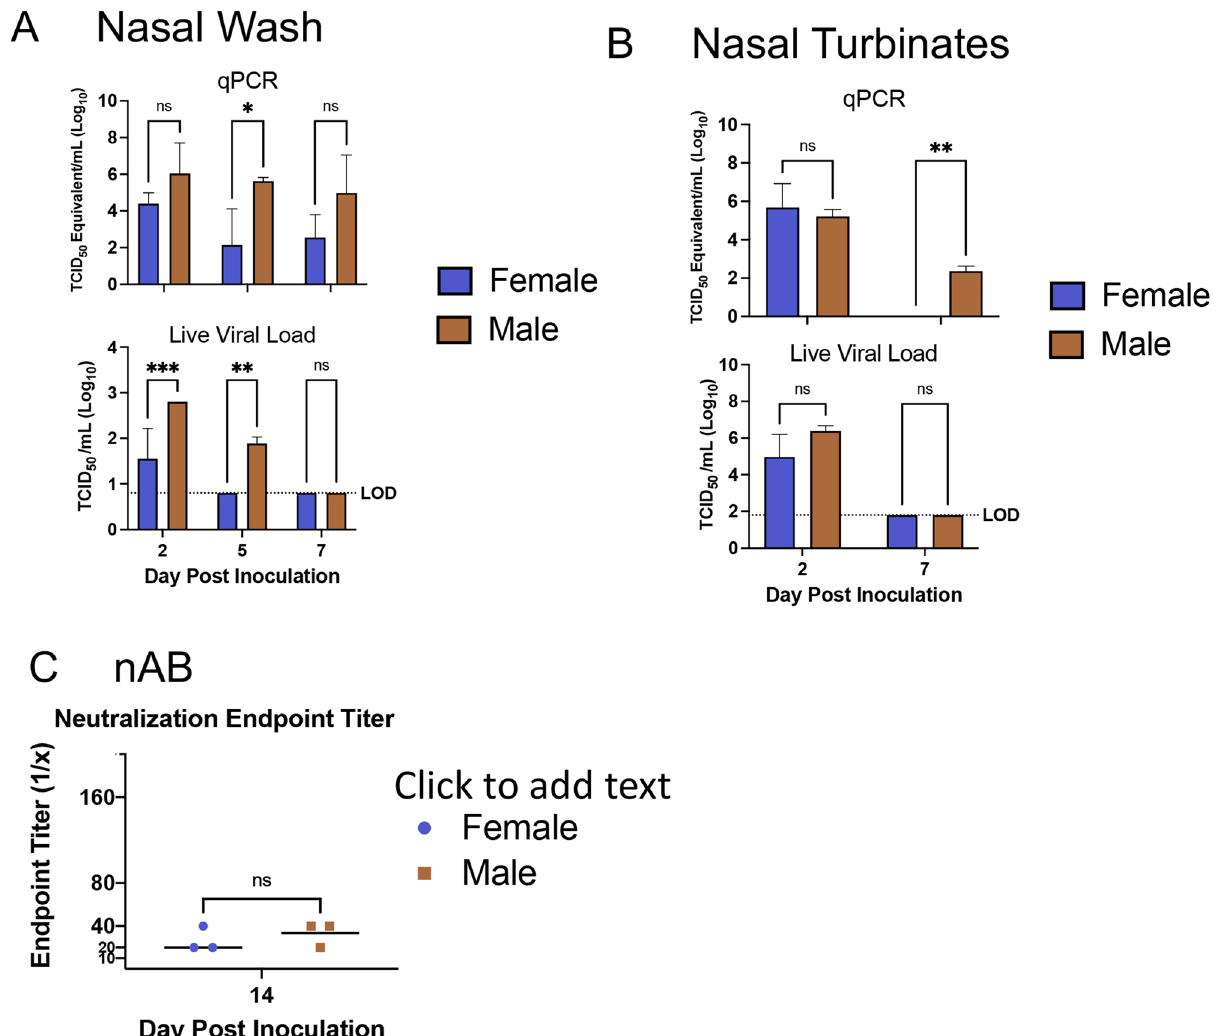
Figure 3. Increased SARS-CoV-2 viral presence occurs after infection in upper respiratory tract of male ferrets. ( A ) Nasal washes were collected from male and female ferrets to quantify SARS-Co-V-2 by qPCR and live viral load assay. Infectious titer of TCID 50 /mL was calculated using the Reed and Muench method. ( B ) vRNA and live virus was also quantified in the nasal turbinates. ( C ) Virus neutralization titers were determined by standard neutralization assays using plasma collected from both groups on day 14. LOD = limit of detection. Error bars represent SD. *A p-value of less than 0.05 as determined by ANOVA or Student’s t-test as appropriate. N is 3 for all the epithelial cells (red arrow) (three of three animals), as well as cavity formation (black arrow) (three of three animals), necrosis (three of three animals), and immune infiltration (three of three animals). Erosion could be seen on days 2 and 7 pi whereas cavity formation in the submucosa was evident on days 7 and 14. Exocytosis of mononuclear cells was consistently observed post infection (three of three animals). Orange arrows point to epithelial cell sloughing. We next investigated viral antigen presence and location within the tissue by IHC for 1-year-old males ver- sus 1-year-old females (Fig. 6A) and 1-year-old males versus 2-year-old males (Fig. 6B). Viral antigen staining was then quantified (Fig. 6C,D). 1-year-old males had a high concentration of positively stained cells in the outer layer of the nasal olfactory epithelium on day 2 (three of three animals), (indicated by red arrows) which diminished by day 7 (green arrows). Comparatively, 1-year-old females had minimal viral antigen staining in the pseudostratified columnar epithelium which was only observed on day 2 pi (three of three animals) (Fig. 6A, indicated by green arrows). When the viral antigen was quantified and compared for the two groups, 1-year-old females had statistically less percentage of tissue stained compared to 1-year-old males (Fig. 6C). Two-year-old males were next compared to the 1-year-old males and similar levels of viral antigen were noted on day 2 pi in the two groups although the distribution and intensity differed (Fig. 6B). Intense staining was found in the outer epithelial layer in the 1-year-old males where has the staining was more diffuse for the 2-year-old males but